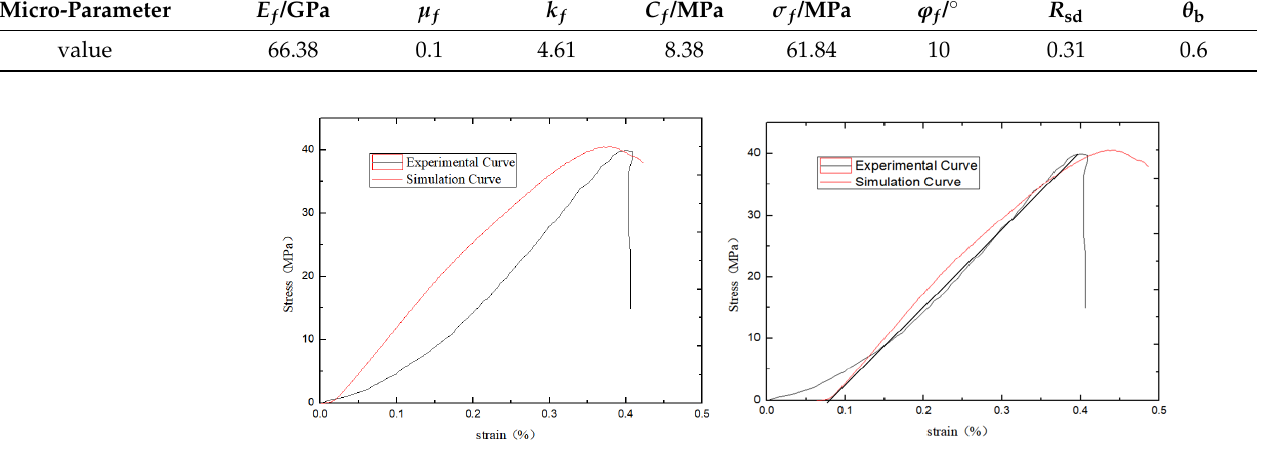
Figure 9. Comparison of experimental data and numerical simulation under uniaxial compression.